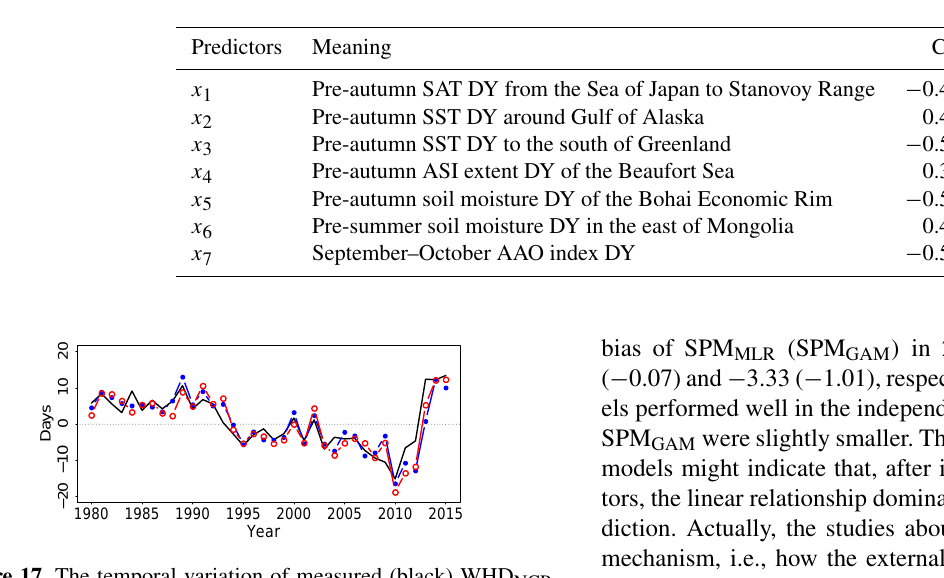
Table 2. The predictors and their meaning. CC indicates the correlation coefficient between predictor and WHD NCP DY from 1980 to 2013.